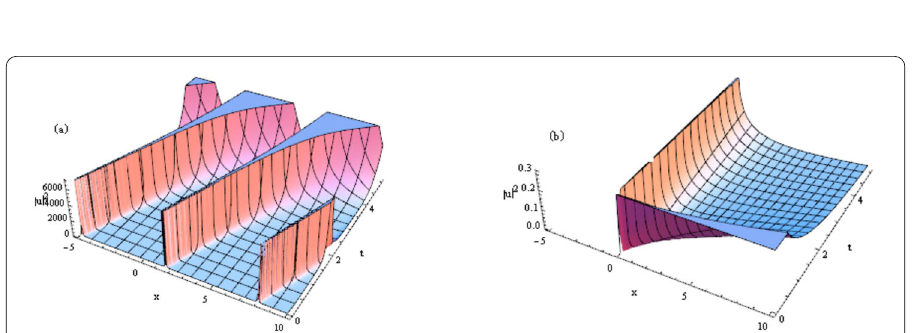
Figure 4 ( a ) The evolution plot of the Jacobi elliptic functions solutions u 27 with the parameters k = k